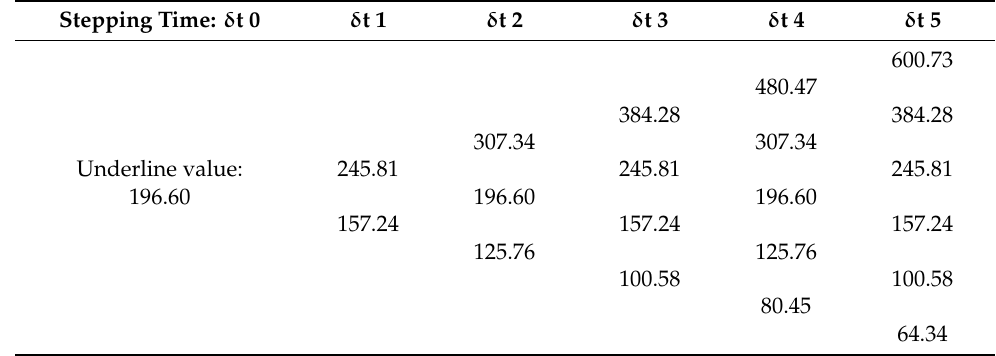
Table 5. Binominal option pricing model: a lattice of the underline values of Samsung Electronics after the acquisition (in $ bn).